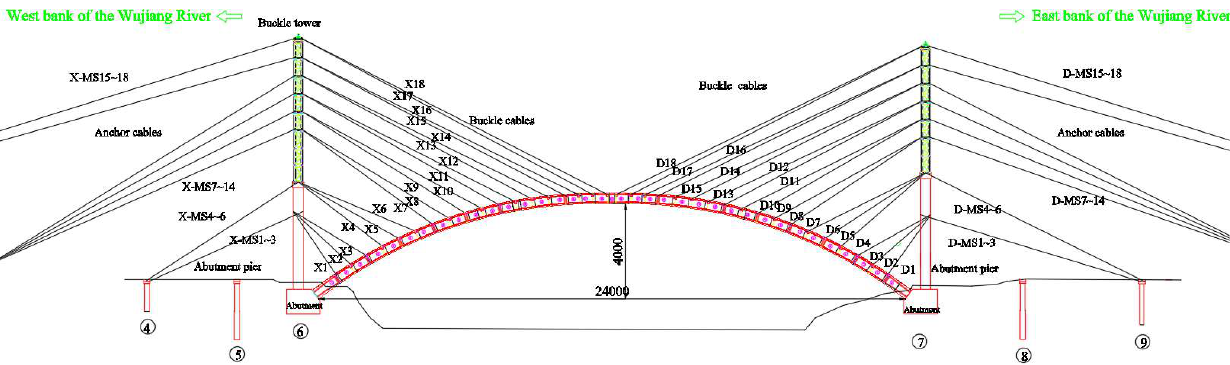
Figure 9. Site layout of the Shatuo Bridge buckling anchor cable. Units in cm.